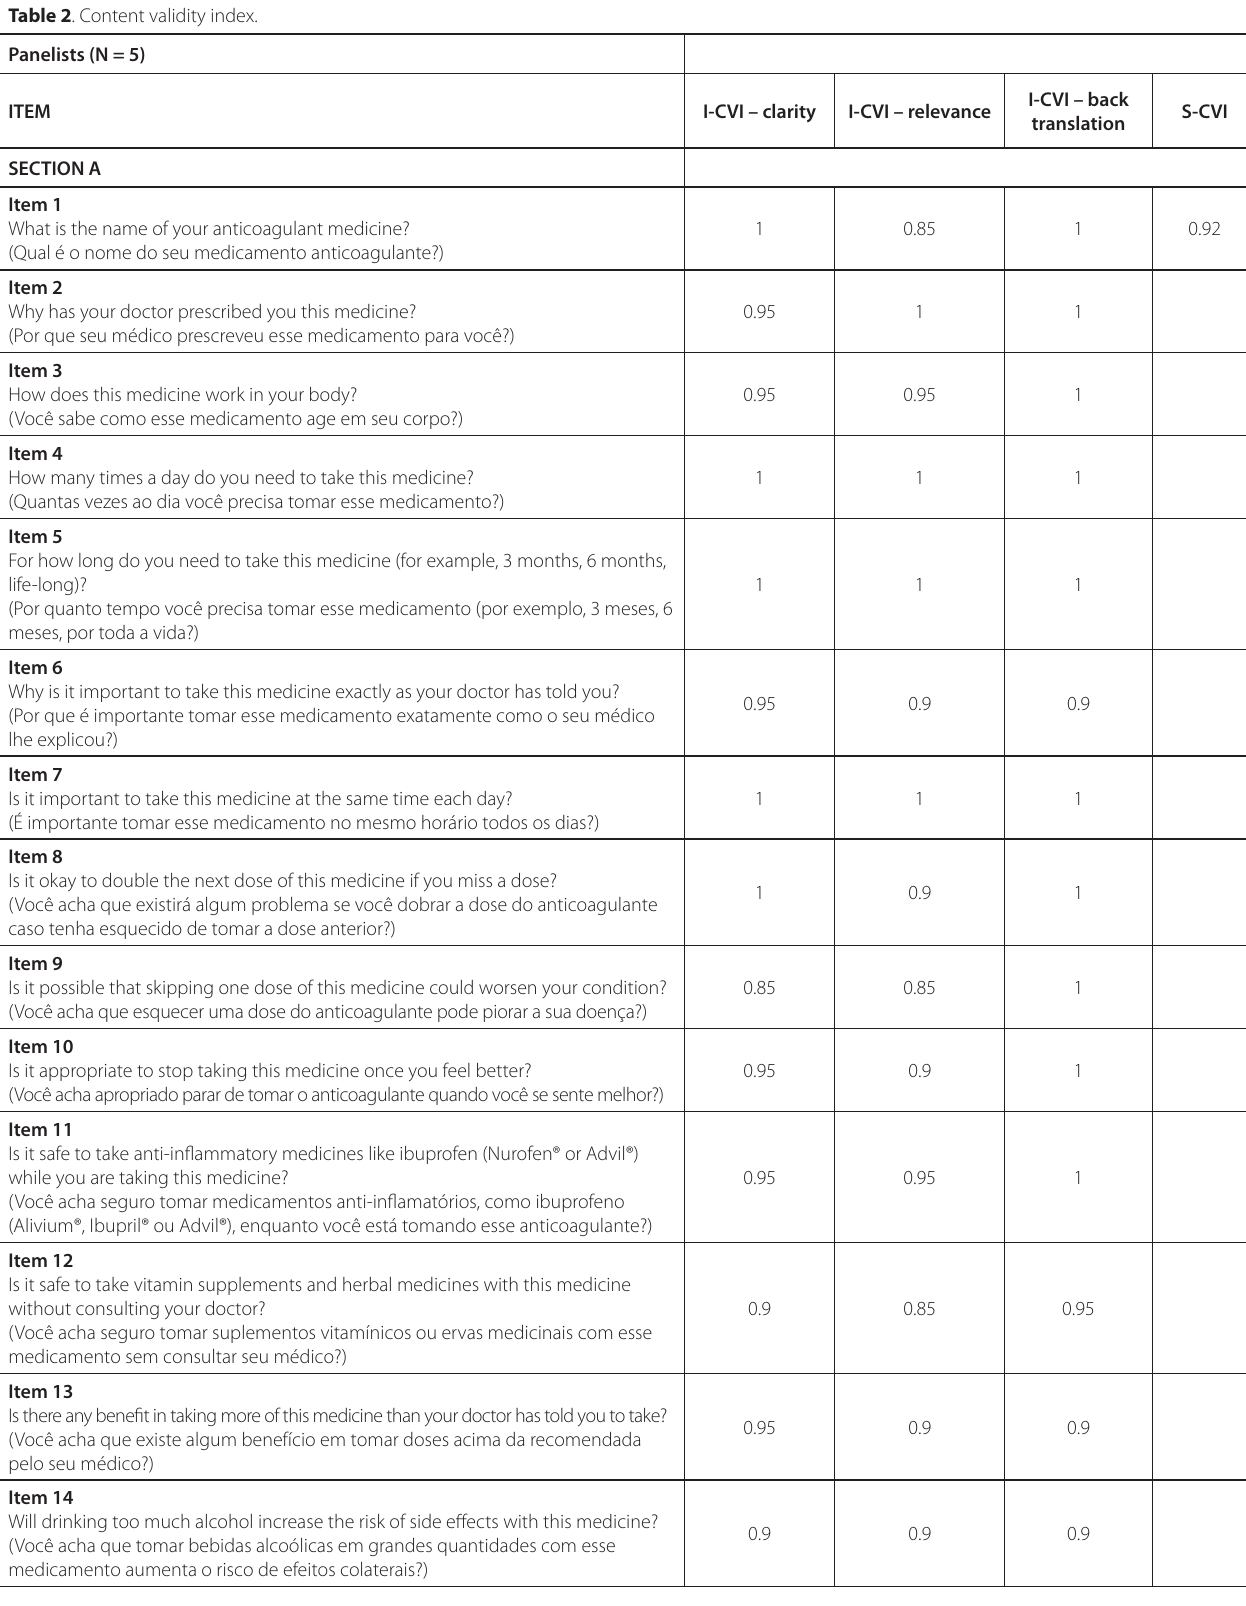
Table 2 . Content validity